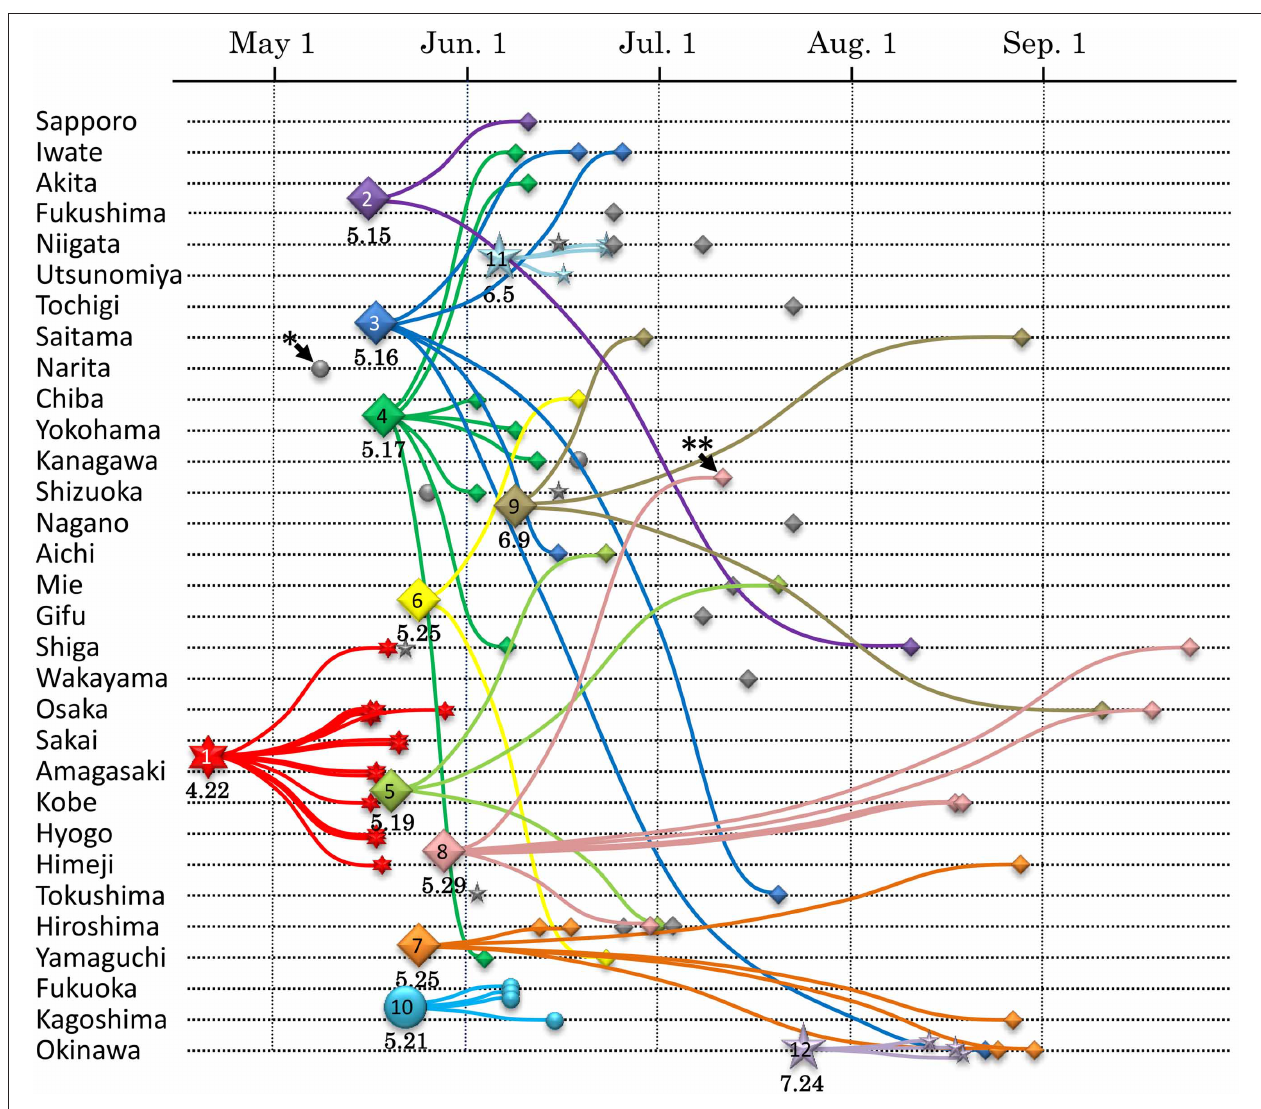
FIGURE 1 | Transmission dynamics of A(H1N1)pdm epidemic in Japan estimated by phylodynamics. The vertical and horizontal axes show geographic localities and the times of virus collection, respectively. Chronological phylogeny was inferred by BEAST v1.5.4 using the general time reversible model, taking into account site heterogeneity and invariant sites (GTR + I + G) and the logistic population model (Drummond and